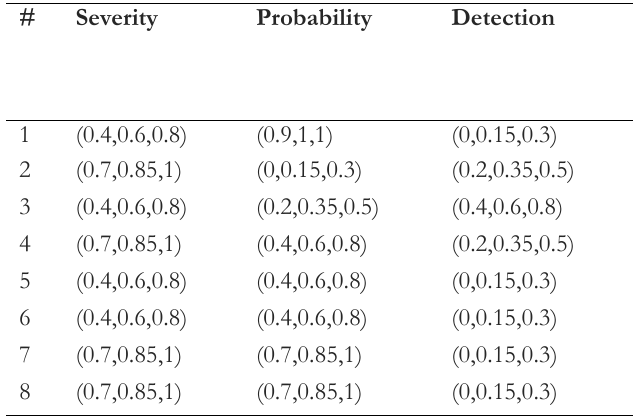
Table 2. Formation of fuzzy membership function for severity, probability, and detection for all 8 potential failure